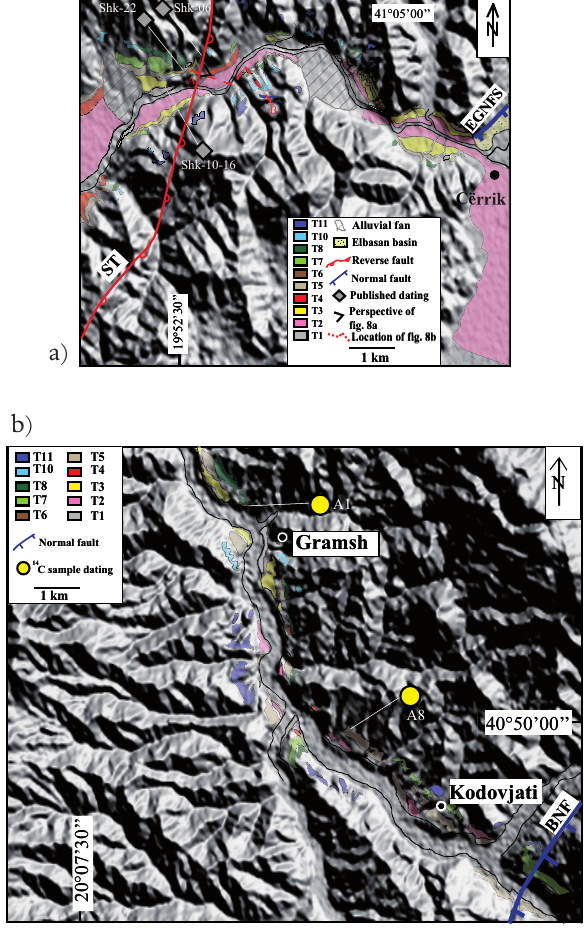
Figure 3. Geomorphic map extracts of the Shkumbin (a) and Devoll (b) rivers. Samples and geographical location mentioned in the text are shown. The location of Figure 8 is also shown. See Supplemen- tary data A (at http://hdl.handle.net/2122/8875) for a regional ge- omorphic map.